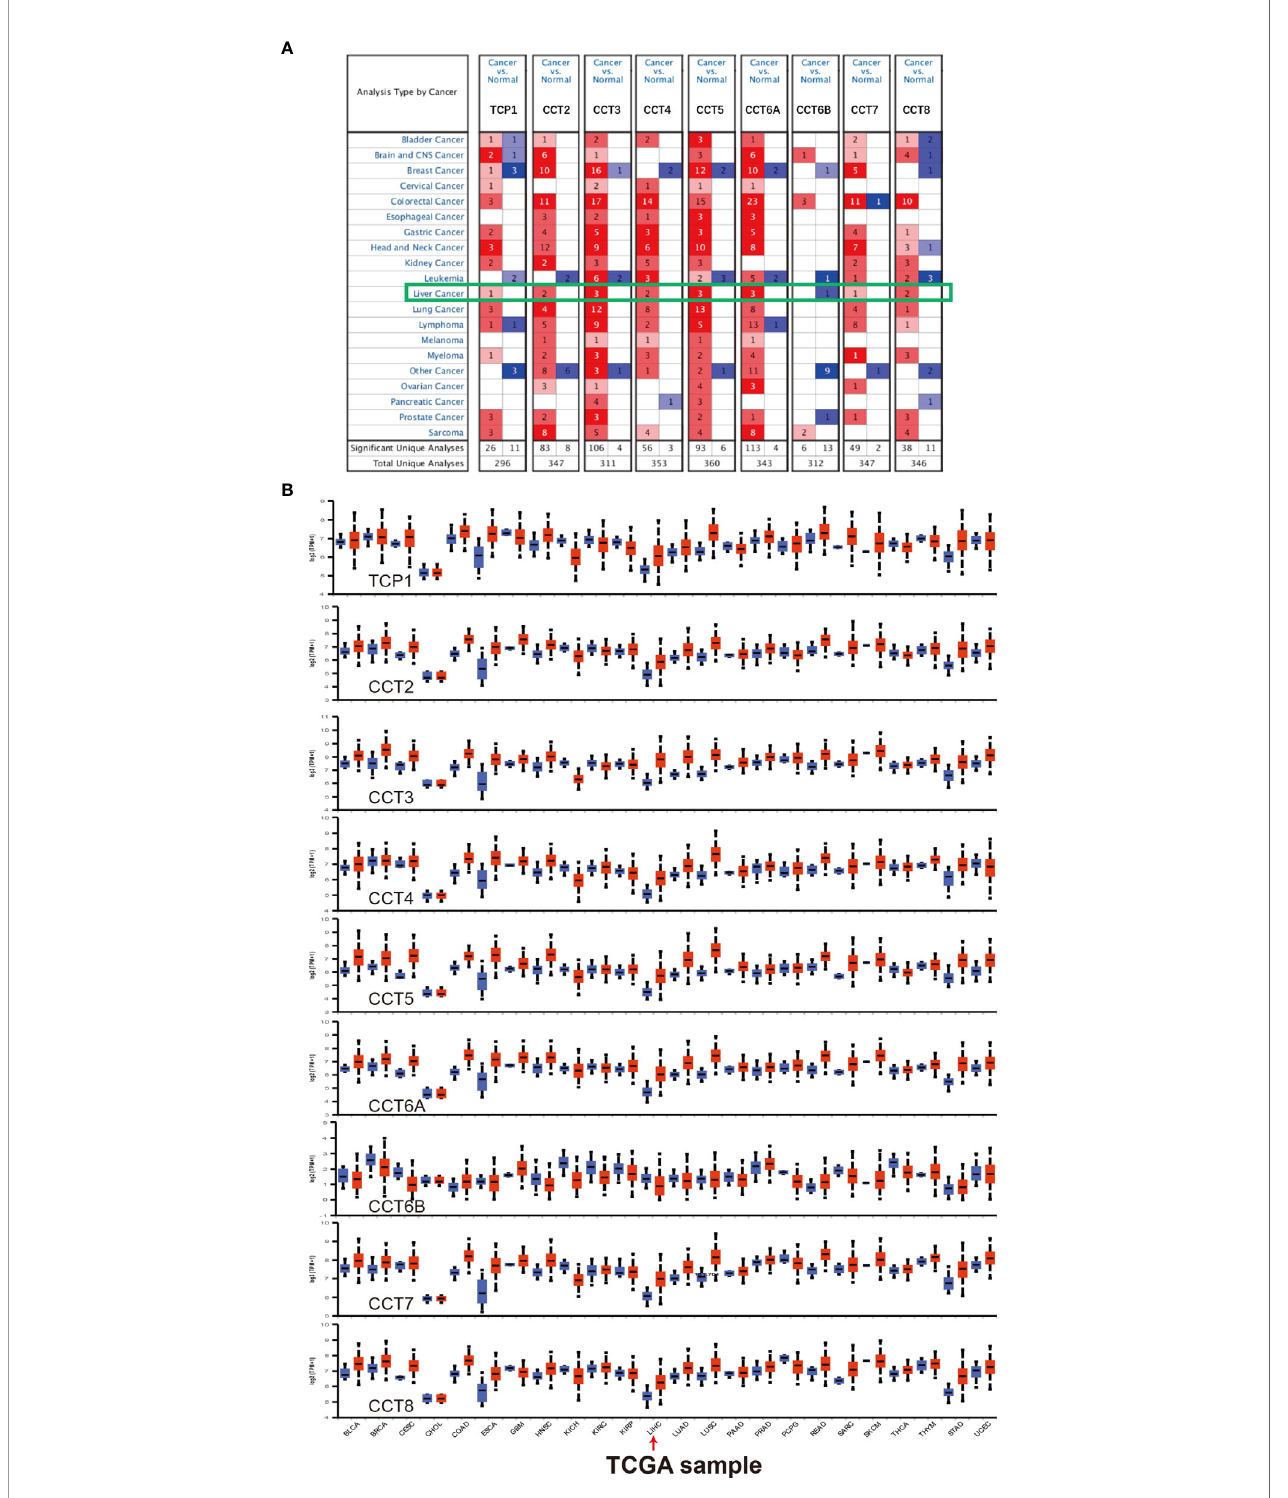
FIGURE 1 | Differential expression of TRiC subunits in 20 different cancer types (from ONCOMINE and UALCAN). (A) Differential expression of CCT mRNAs in various cancer types compared to corresponding normal tissues (from the ONCOMINE database). Red: overexpression; Blue: downregulated expression (threshold fold-change of 1.5, p < 0.01 for signi fi cance, gene rank: 10%, data type: mRNA). (B) Differential CCT mRNA expression levels in various cancer types compared to normal tissues (from the UALCAN